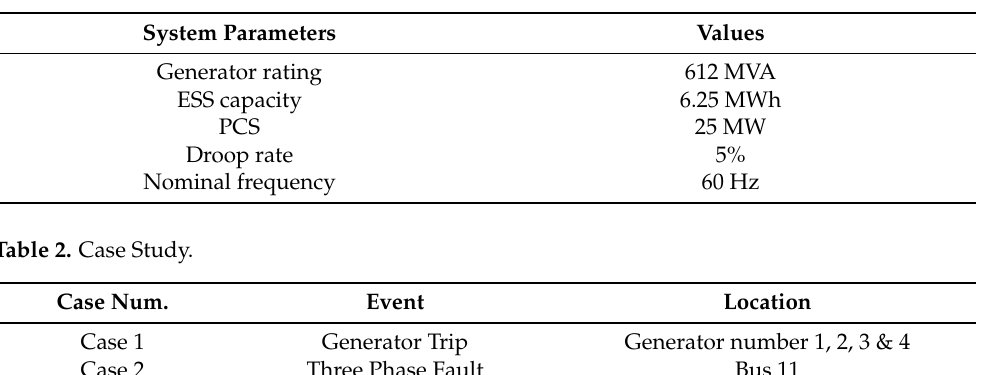
Table 1. Parameters of Target Generator.